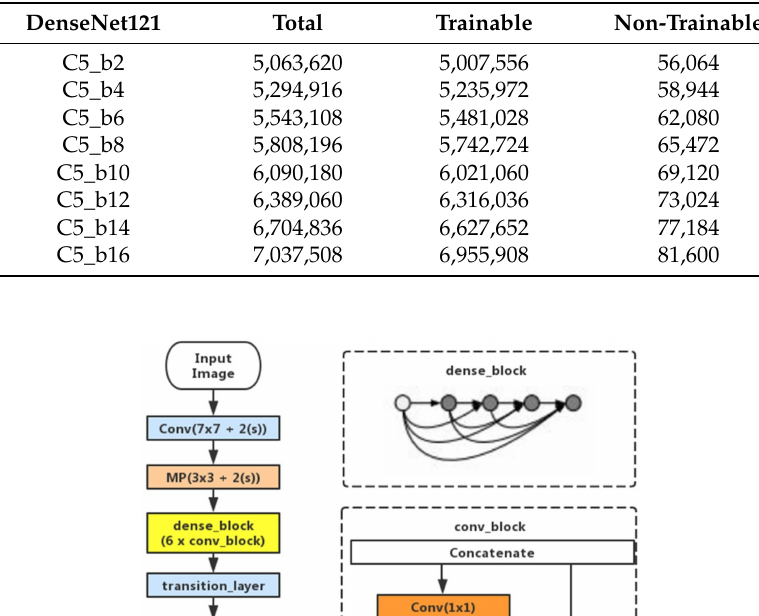
Table 3. The number of parameters in DenseNet121 sub-networks.